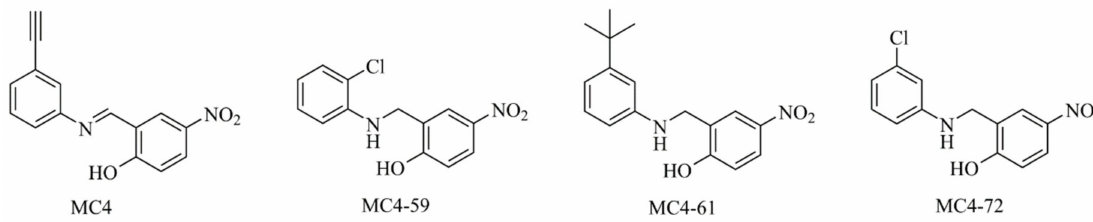
Figure 1. The chemical structures of selected nusbiarylins studied in this work. MC4, the lead compound, and its derivatives MC4-59, MC4-61 and MC4-72